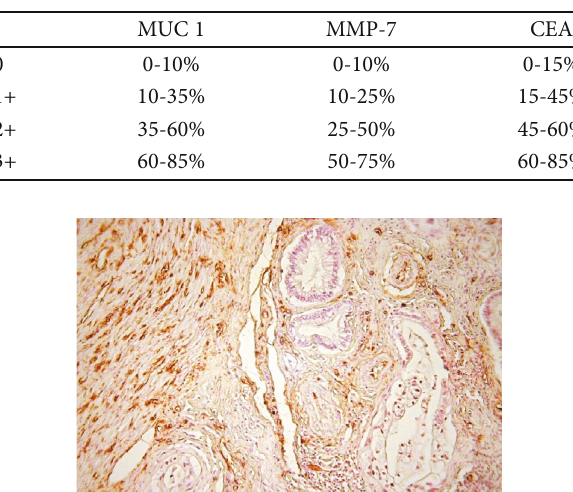
Figure 6: Distribution of immunohistochemical marker positivity. Table 1: Staining index, according to the scale used (0-3+) for the fi rst 3 markers with the highest positivity.